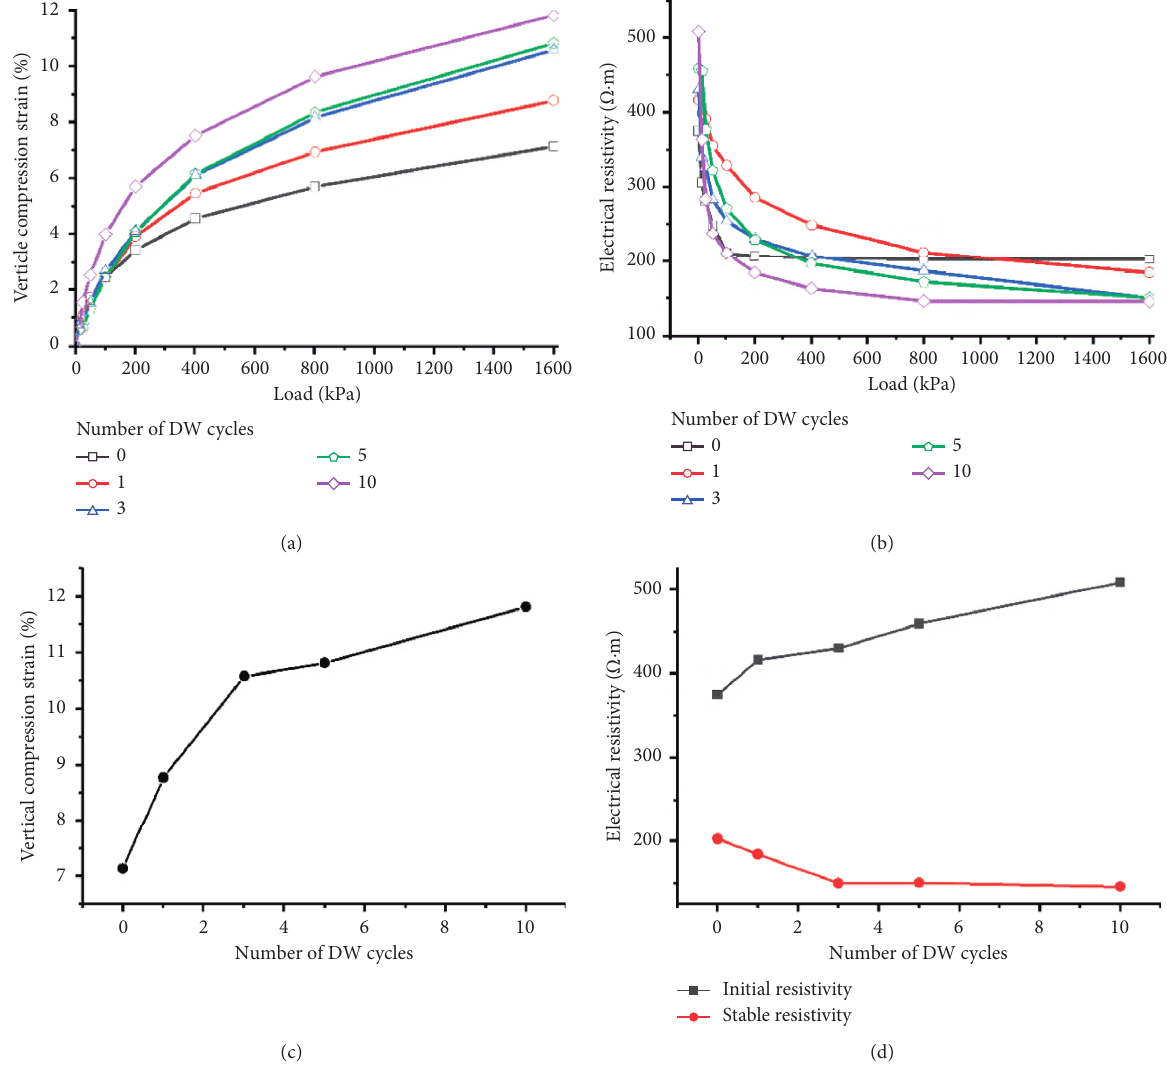
Figure 11: Deformation and electrical resistivity characteristics of loess specimens under different loads and DW cycles: (a) relationship between vertical compression strain and loads under different DW cycles; (b) relationship between electrical resistivity and loads under different DW cycles; (c) relationship between vertical compression strain and DW cycle numbers; (d) relationship between electrical resistivity and DW cycle